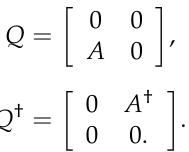
Figure 1. The energy levels of V 1 ( x ) and V 2 ( x ) as two supersymmetric partner potentials. The figure is associated with unbroken SUSY. It is seen that, except an extra state E energy levels are degenerate. Moreover, in this figure, it is shown that how the operators A and A † connect